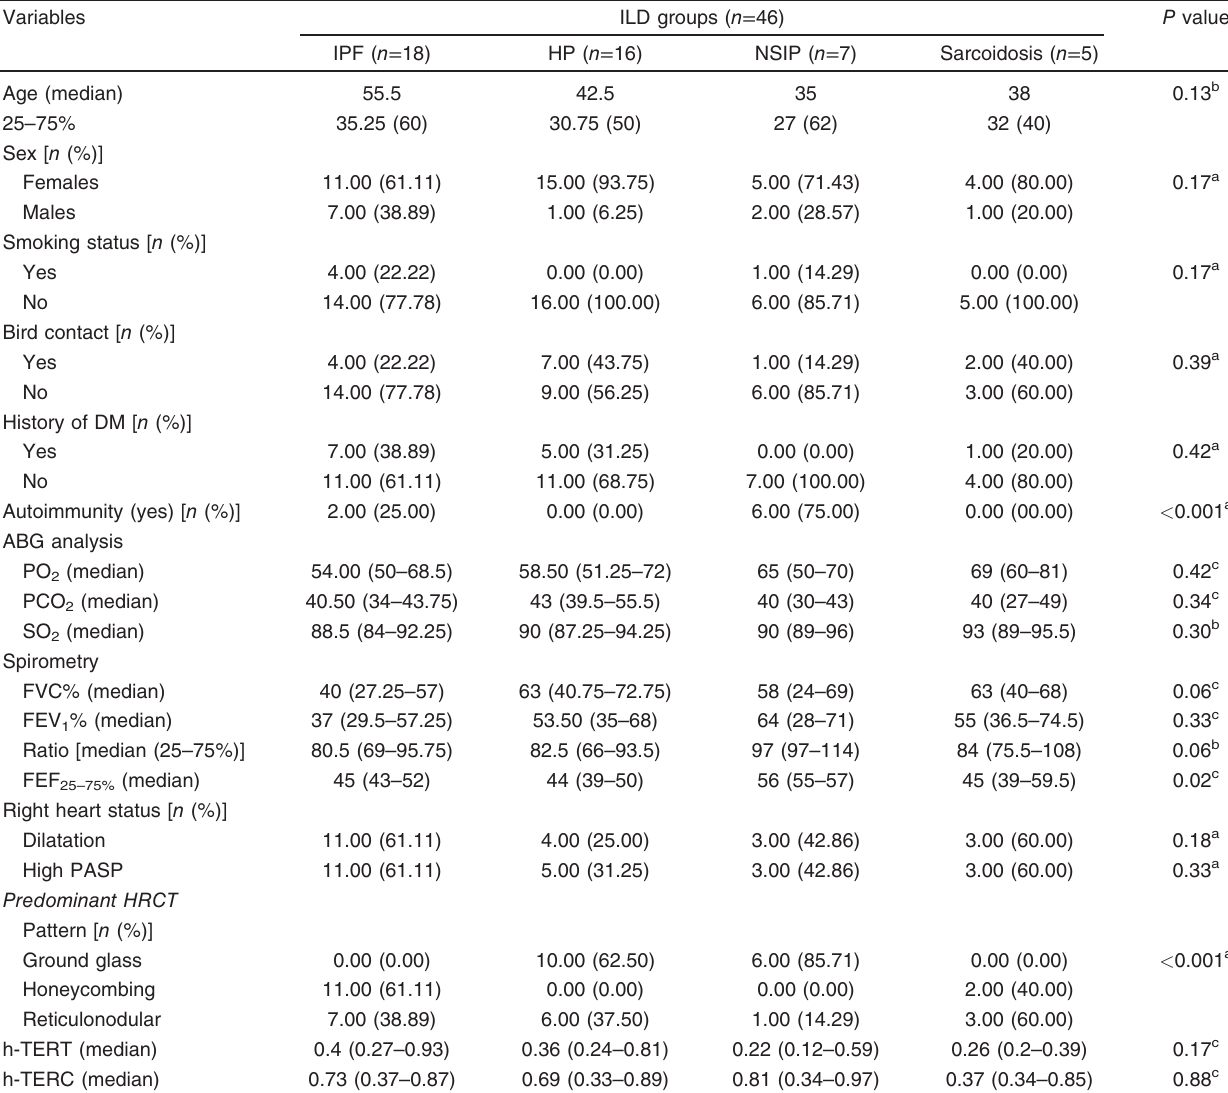
Table 2 Comparison between different histopathological subtypes of interstitial lung disease study group